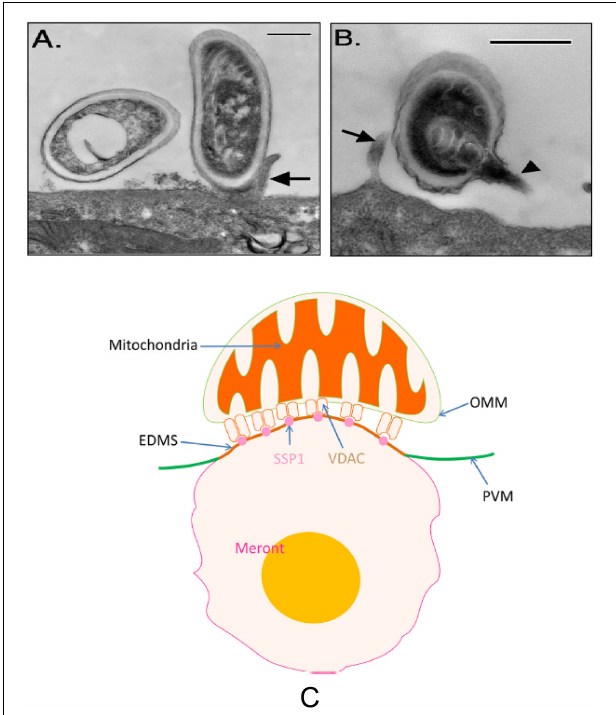
FIGURE 5 | Transmission electron microscopy of E. intestinalis spores attached to Caco-2 cell surfaces. The attached spores appear to be in direct contact with the cell surface or microvilli and have either intact, unextruded polar filaments (A) or extruded PTs (B). Bar is 500 nm. Arrows show host cell microvilli, and the arrowhead points to the E. intestinalis PT. Reprinted with permission of the author (JR Hayman) and the publisher (Hayman et al., 2005). (C) A model of the binding of mitochondria with the parasitophorous vacuole via the interaction of VDAC on the out mitochondria membrane with SSP1 on the surface of meronts. Reprinted with permission of the publisher (Han et al.,